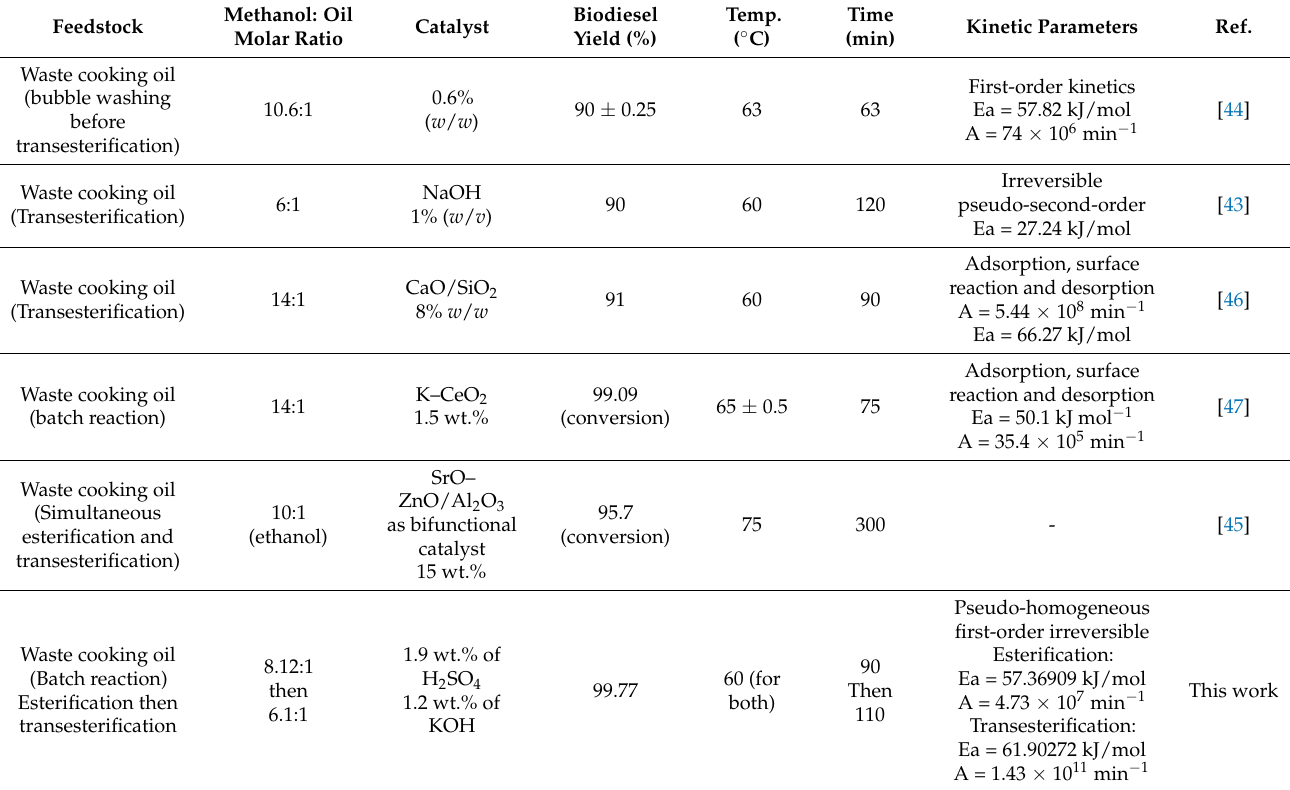
Table 6. Optimal reaction parameters and kinetics of the transesterification process of